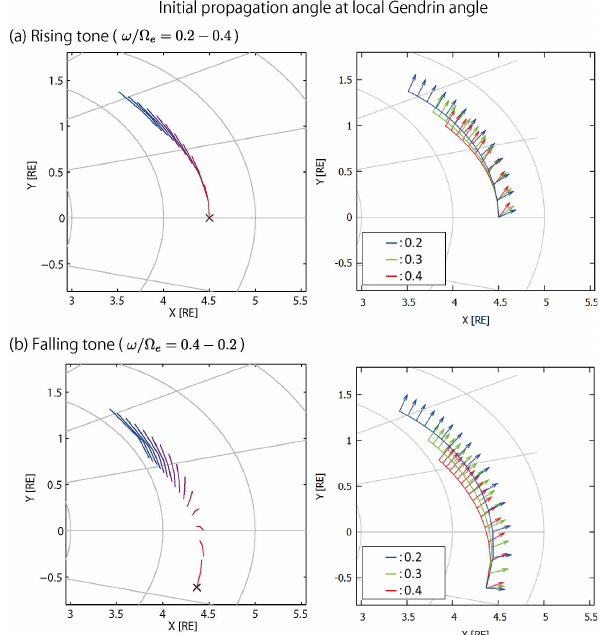
Fig. 5. Expanded equatorial view for L = 4 . 5 for lower-band rising and falling tone, f = 0 . 2–0.4 (cid:127) e / 2 π (Hz) and f = 0 . 4–0.2 (cid:127) e / 2 π (Hz), respectively. Rising tone is generated at the equator, falling tone 4000km upstream from the equator. Left-hand panels show pulse evolution with time; the right-hand panels show k vector evo- lution for three selected frequencies, f = 0 . 2, 0.3, 0.4 (cid:127) e / 2 π (Hz).